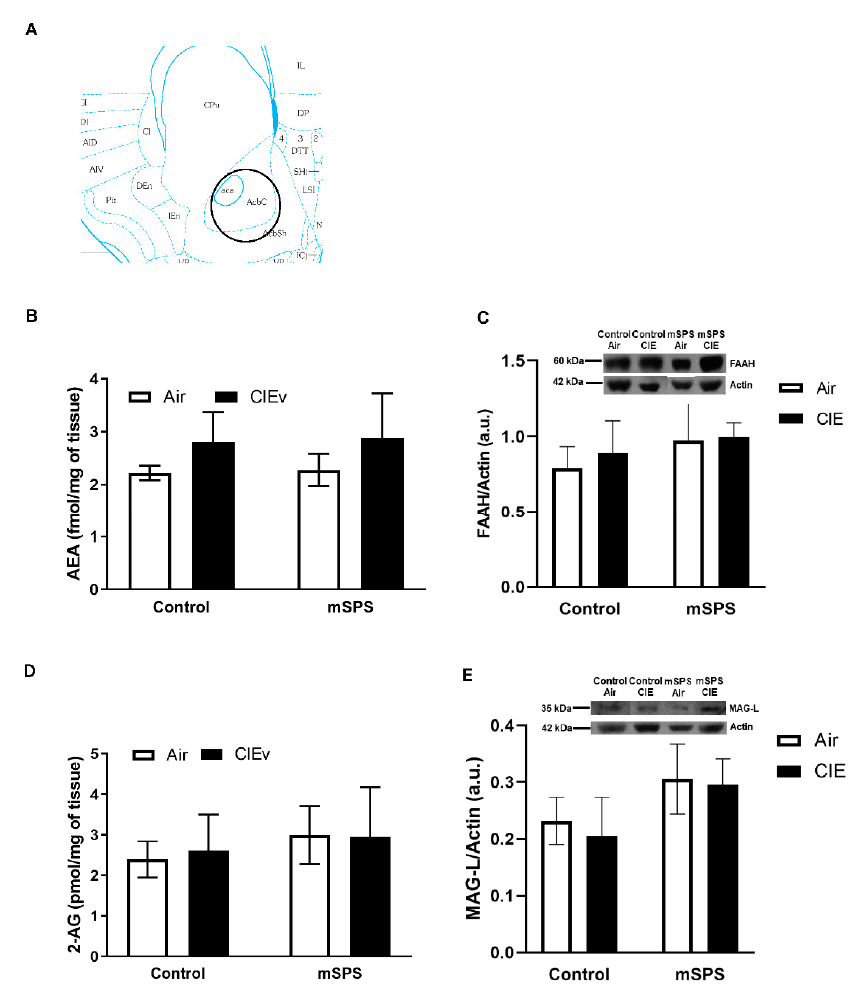
Figure 3. Anandamide (AEA) and 2-arachidonoylglycerol (2-AG) contents, fatty acid amide hydro- lase (FAAH) and monoacylglycerol lipase (MAG-L) levels in the nucleus accumbens (NAc) after mSPS/Control or Air/CIE exposures. ( A ) Schematic of coronal slice where NAc tissue punches were taken bilaterally (adapted from [58]). Average ( B ) AEA content (Control-Air: n = 3; Control CIE: n = 5; mSPS-Air: n = 6; mSPS-CIE: n = 6) and ( C ) FAAH levels (Control-Air: n = 7; Control CIE: n = 4; mSPS-Air: n = 5; mSPS-CIE: n = 8) (Inset: representative immunoblotting sample images) did not change among groups after mSPS/Control or Air/CIE exposures. The average ( D ) 2-AG content (Control-Air: n = 3; Control CIE: n = 6; mSPS-Air: n = 6; mSPS-CIE: n = 7) and the average ( E ) MAG-L levels (Control-Air: n = 7; Control CIE: n = 4; mSPS-Air: n = 5; mSPS-CIE: n = 8) (Inset: representative immunoblotting sample images) did not change among groups after mSPS/Control or Air/CIE exposures. Data are mean ± SEM.